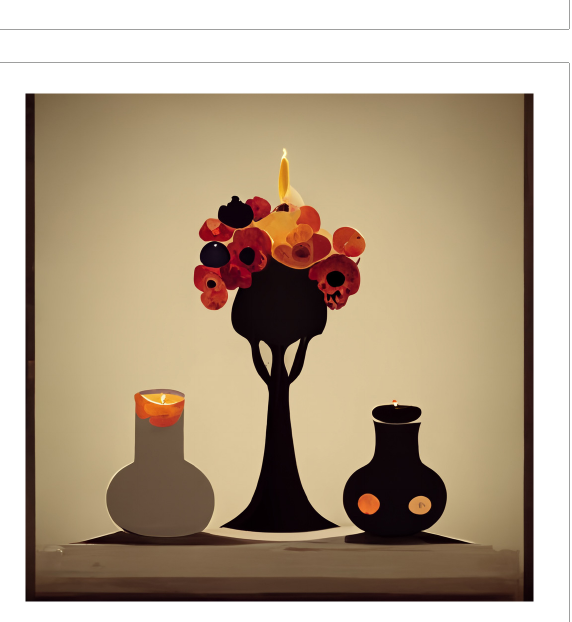
FIGURE2 Midjourney image generated to the prompt “a still life with fruit, flowers, a vase, dead game, a candle, and a skull in an Expressionist style”.